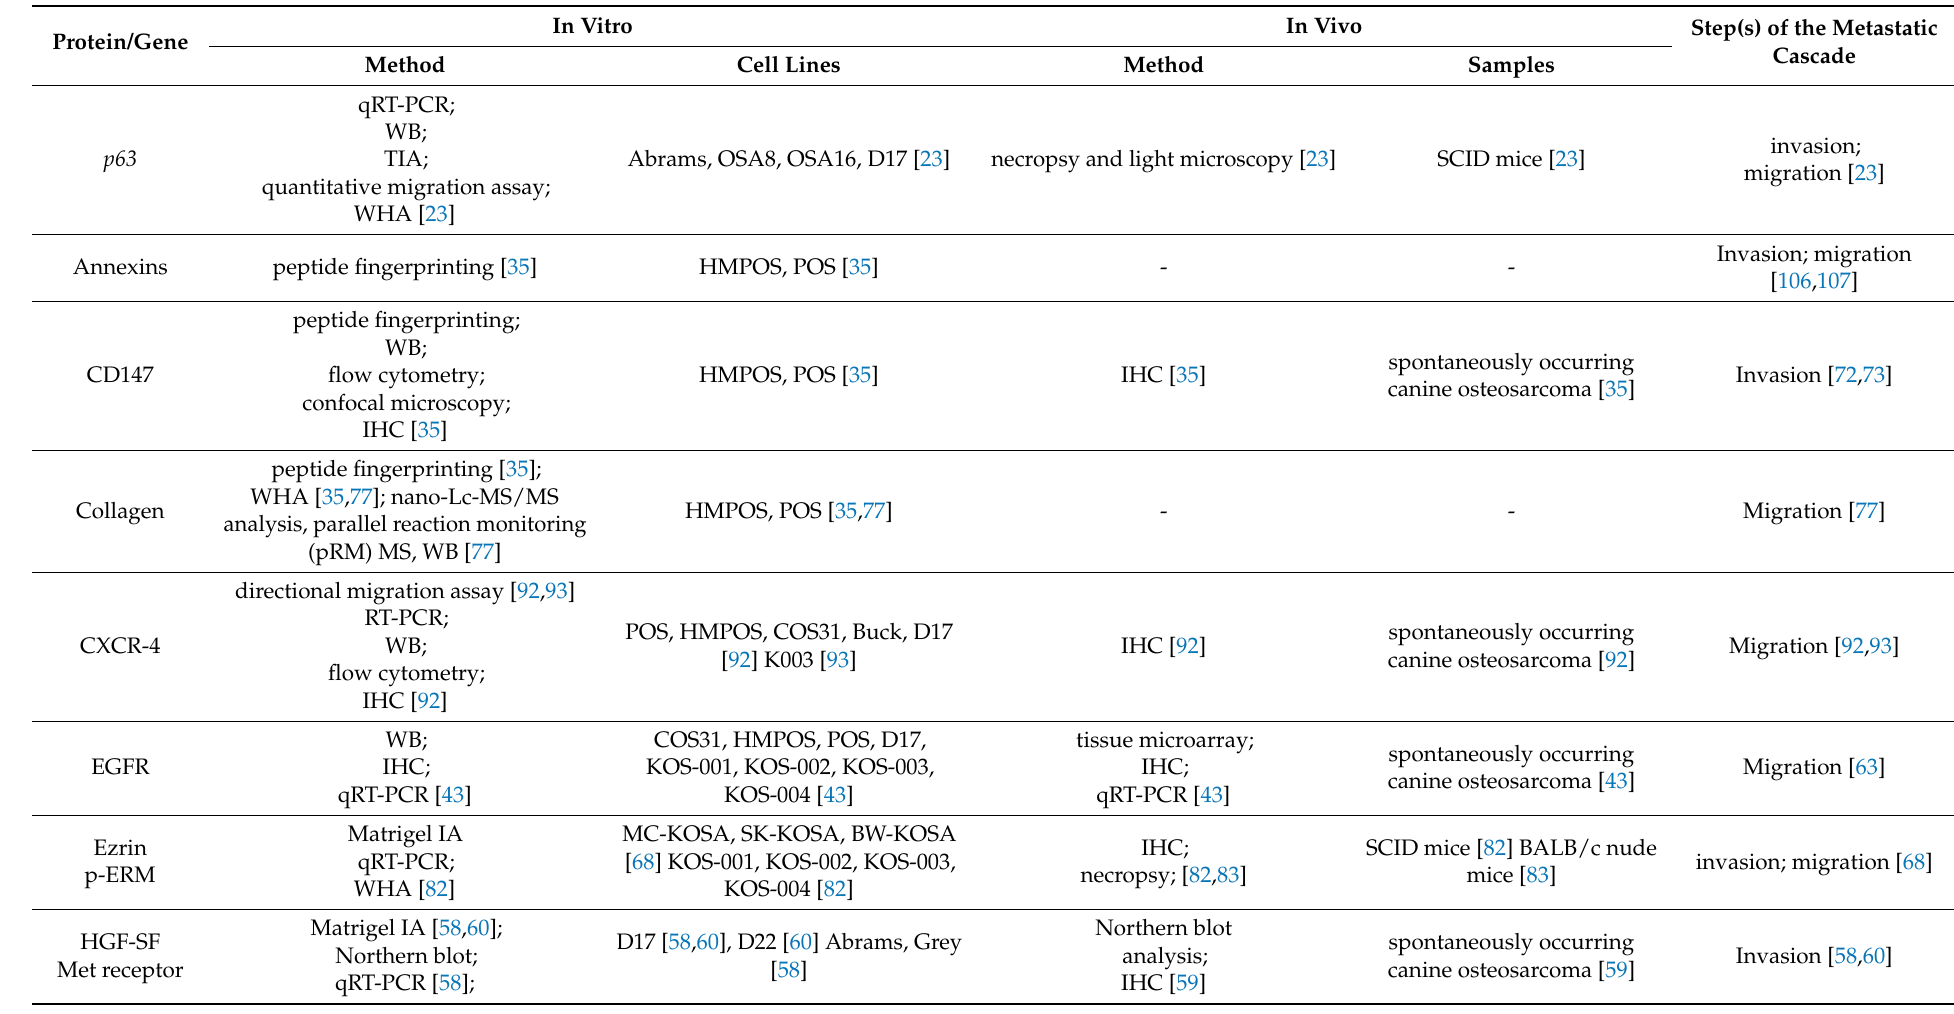
Table 1. Proteins and genes potentially involved in canine OSA metastasis evaluated with particular in vitro and/or in vivo methods. In Vitro In Vivo Step(s) of the Metastatic Protein/Gene